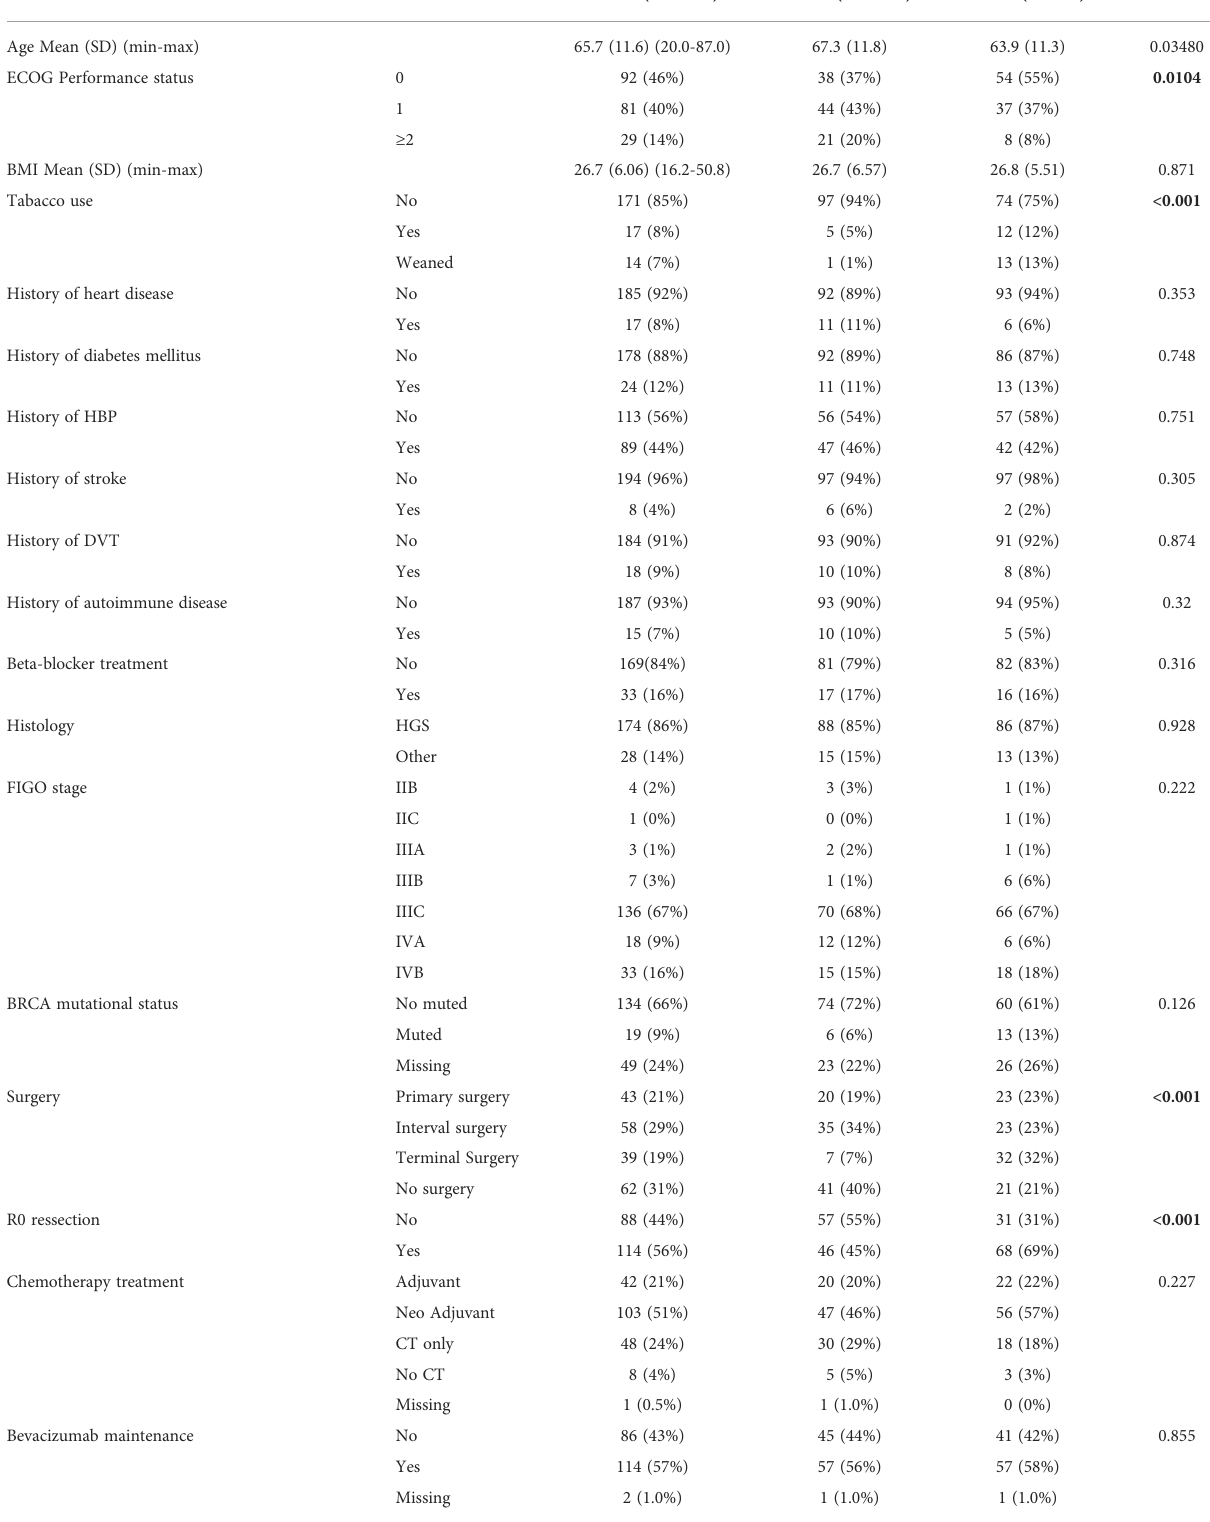
TABLE 1 Patient and tumor characteristics of the global population and in each cancer